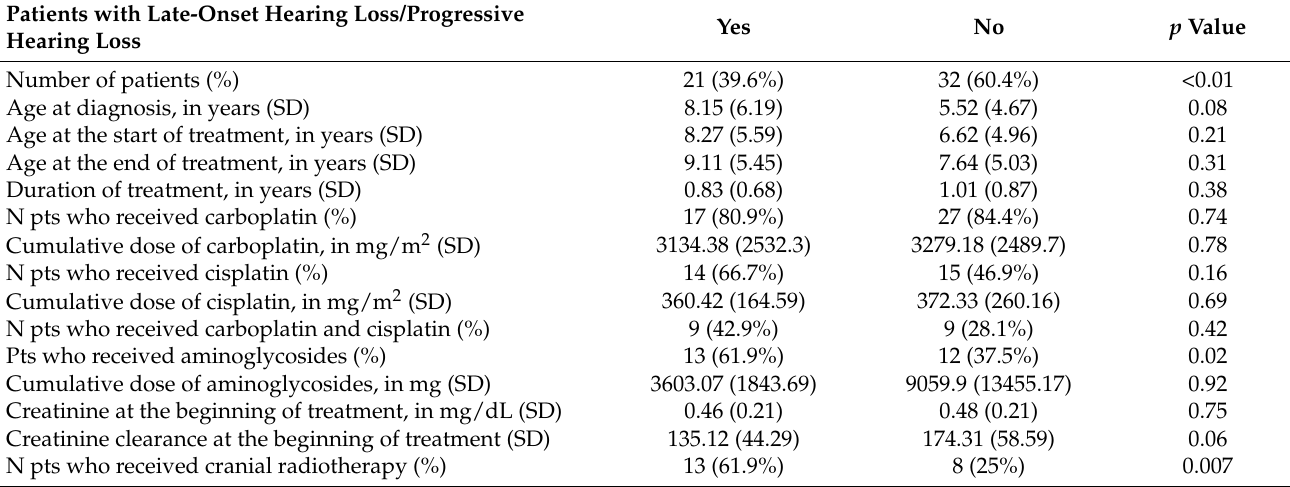
Table 3. Comparison between patients with late-onset hearing loss/progressive hearing loss and patients with stable hearing at the end of the 5 years of observation.